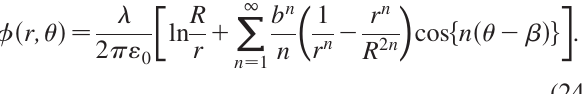
duct with circular cross section in the 2D transverse plane (polar